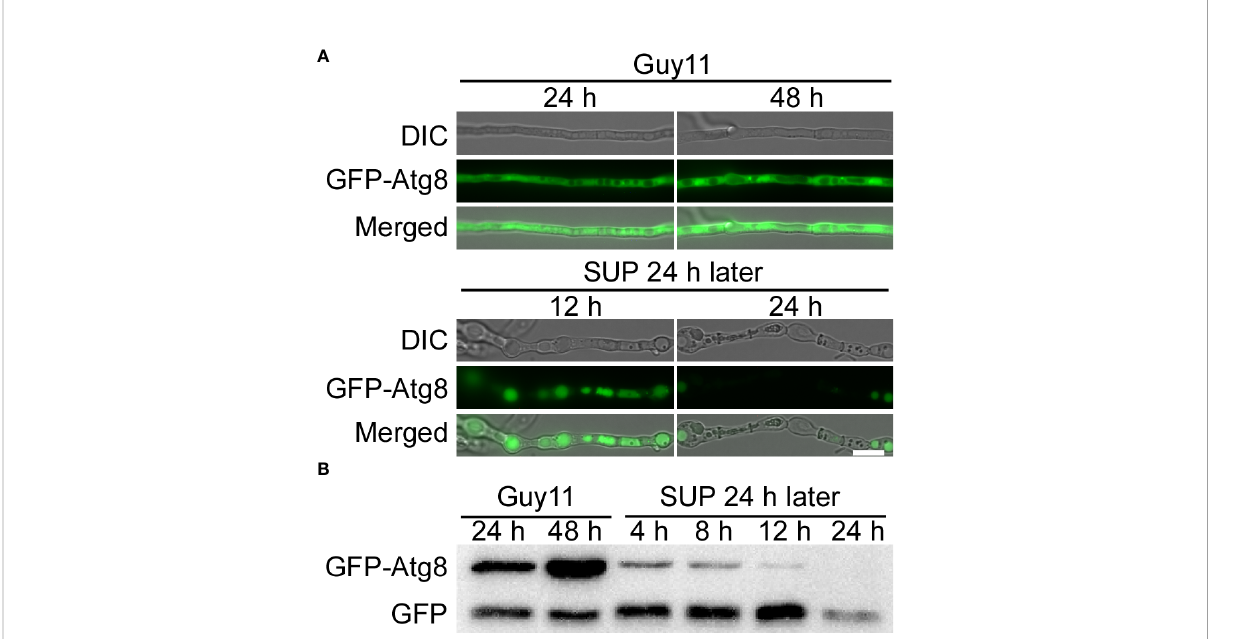
FIGURE 7 KC81 SUP promotes cell autophagy of M. oryzae . (A) Live cell imaging experiment to show GFP-Atg8 localization in M. oryzae mycelium in the presence or absence of KC81 SUP. (B) Immunoblotting was performed with anti-GFP antibodies. The extent of autophagy was estimated by calculating the amount of free GFP compared with the total amount of intact GFP-Atg8 and free GFP. Bar = 10 m